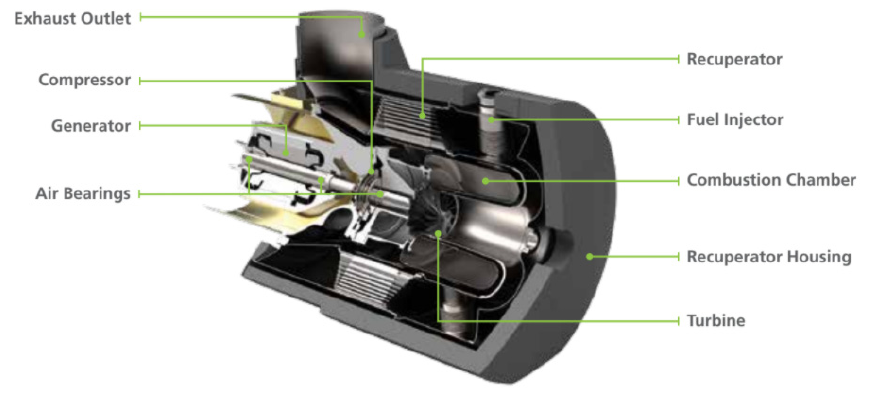
Table 6. PROs and CONs of a micro-gas turbine.